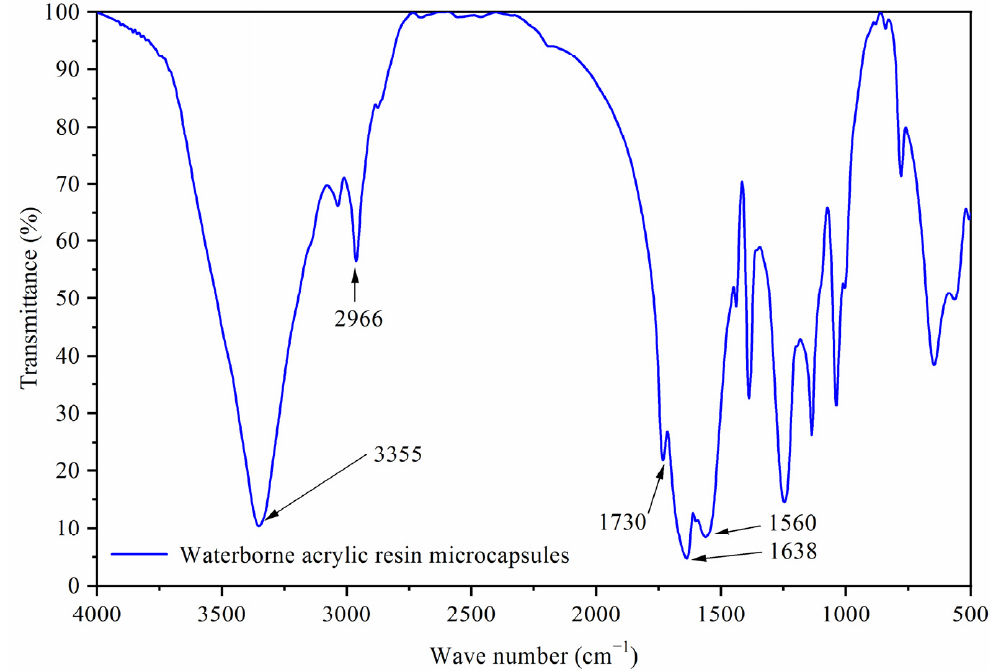
Figure 2. Infrared spectrum of waterborne acrylic resin